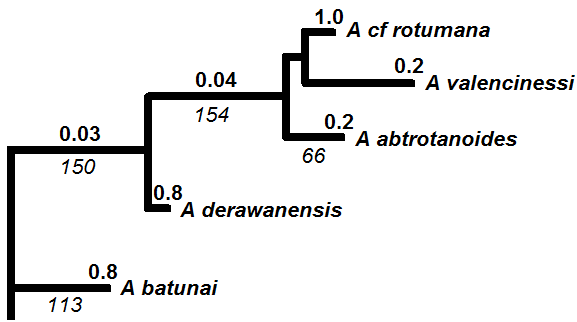
Figure 5. Subset of the larger phylogenetic tree (Figure 2). Relevant branch lengths are shown below branch, in italics. Estimated probabilities of extinction (following Table